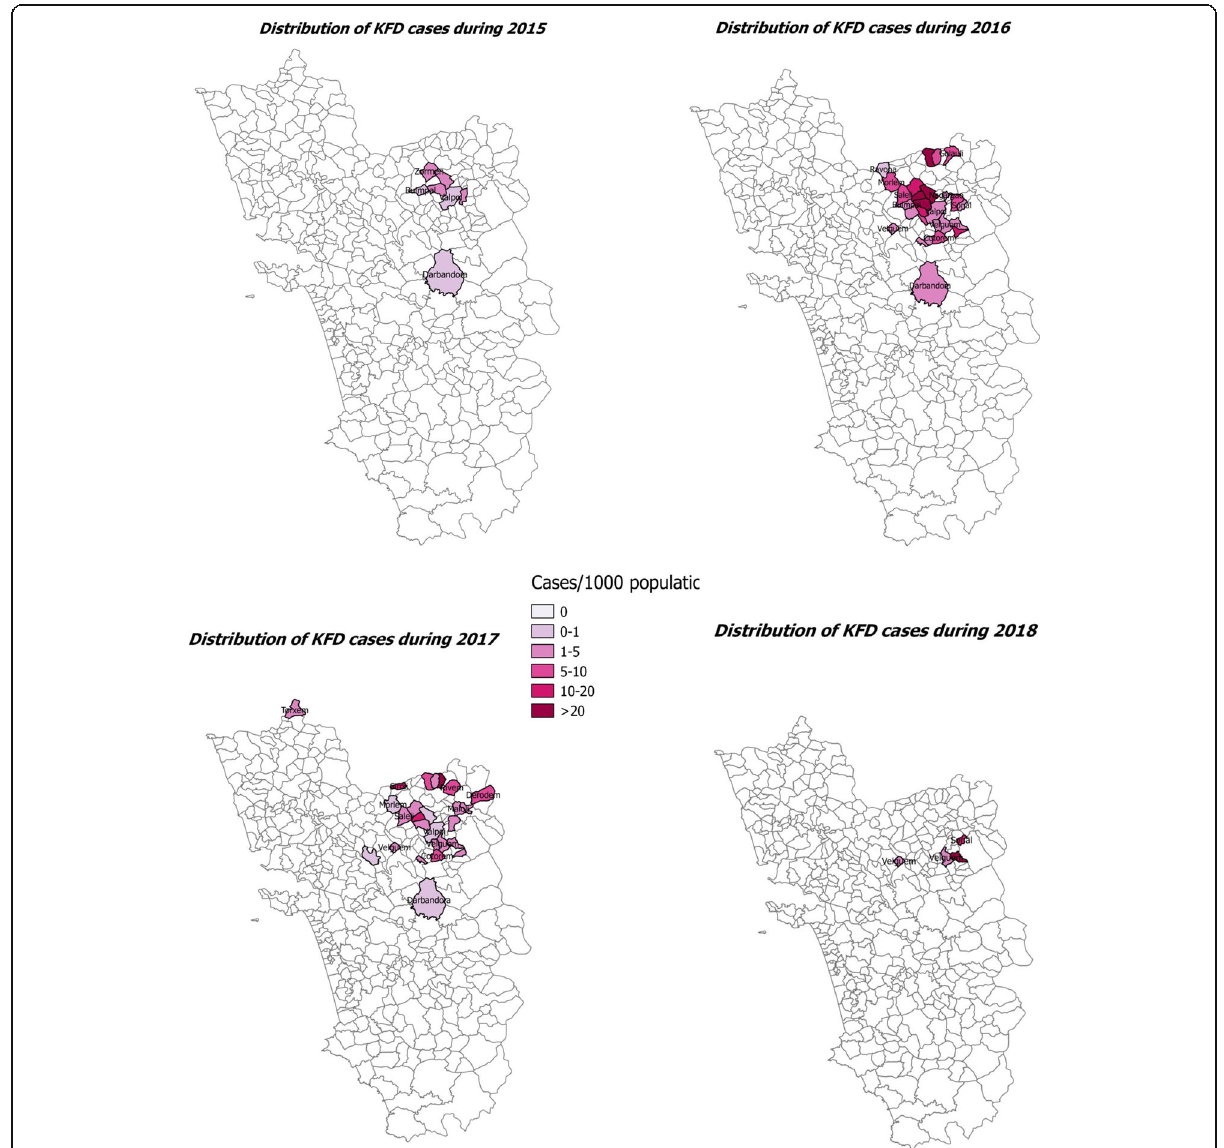
Fig. 9 Spatio-temporal distribution of cases of Kyanasur Forest Disease in Goa, India, during 2015 –